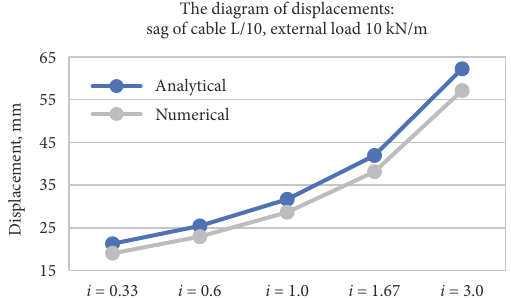
Figure 8. The diagram of displacements, when the load is distributed, the string is not